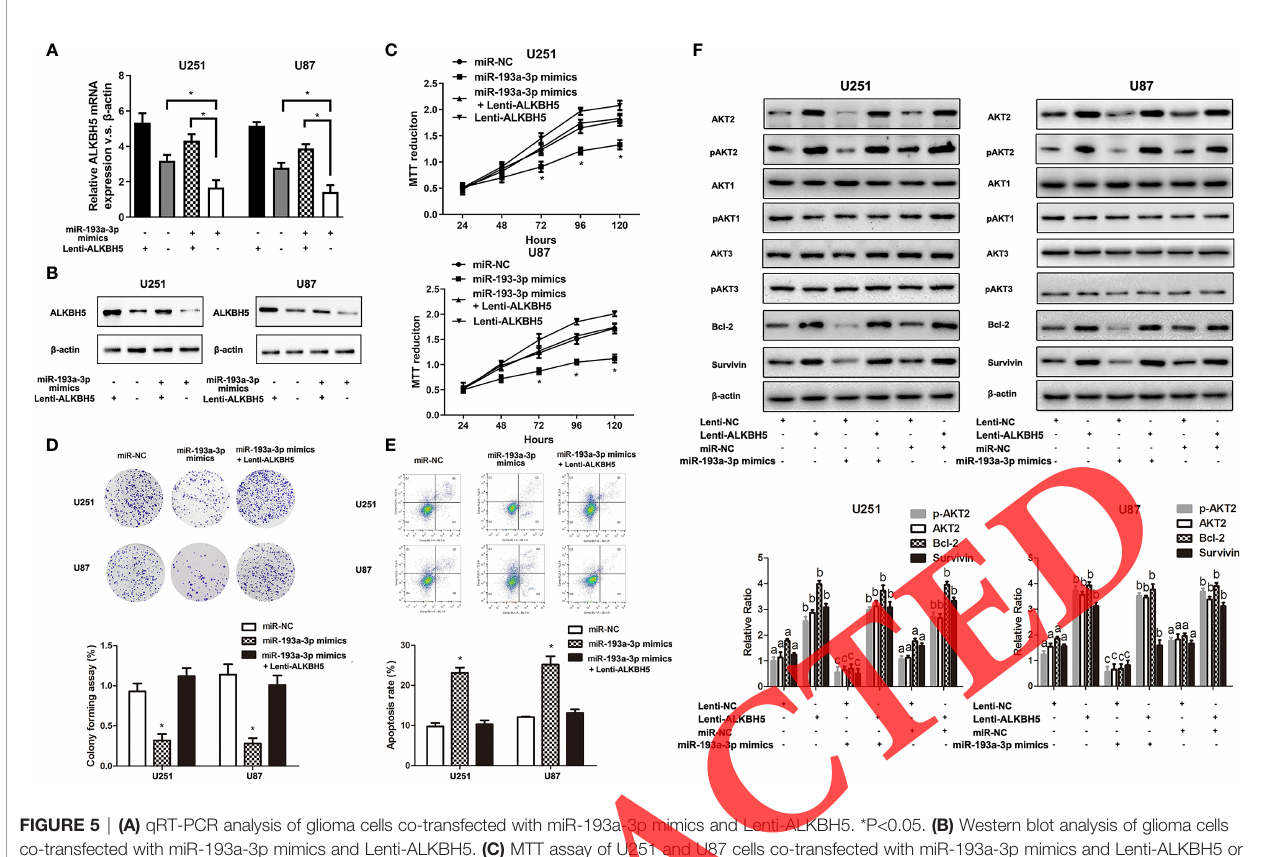
FIGURE 5 | (A) qRT-PCR analysis of glioma cells co-transfected with miR-193a-3p mimics and Lenti-ALKBH5. *P<0.05. (B) Western blot analysis of glioma cells co-transfected with miR-193a-3p mimics and Lenti-ALKBH5. (C) MTT assay of U251 and U87 cells co-transfected with miR-193a-3p mimics and Lenti-ALKBH5 or the control. *P<0.05. (D) Colony formation assay of U251 and U87 cells co-transfected with miR-193a-3p mimics and Lenti-ALKBH5 or the control. *P<0.05. (E) Apoptosis assay of U251 and U87 cells co-transfected with miR-193a-3p mimics and Lenti-ALKBH5 or the control. *P<0.05. (F) Top: ALKBH5 overexpression blocks the effect of miR-193a-3p on total AKT2 and AKT2 phosphorylation expression without affecting total AKT1, total AKT3, p-AKT1 and p-AKT3expression. MiR-193a-3p suppresses Bcl-2 and Survivin protein expression through ALKBH5. Bottom: Quantitative analysis of Western blot analysis. Values representing the mean ± SD (n= 3) with different letters are signi fi cantly different.